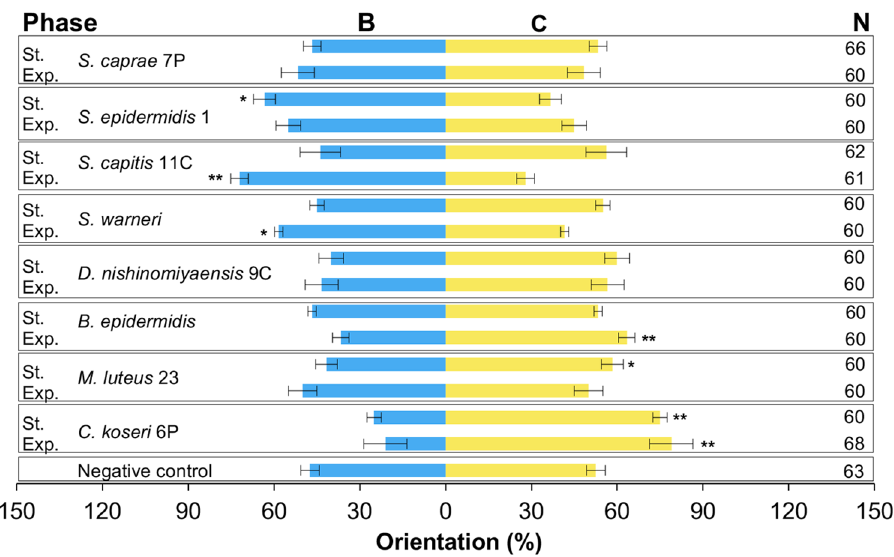
Fig 2. Behavioral responses of R . prolixus to VOCs produced in vitro by eight bacterial species. Bacterial species were tested in exponential growth phase (Exp) and in stationary growth phase (St). B = standard liquid medium with bacteria, and C = standard liquid medium without bacteria. N = Number of insects tested. (cid:3) : P < 0.05. (cid:3)(cid:3) : P <